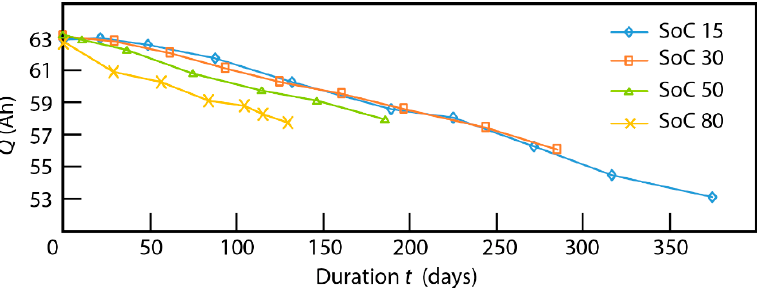
Figure 1. Evolution of the remaining cell capacity with respect of time, for aging at 45 °C at different state of charge (SOC).